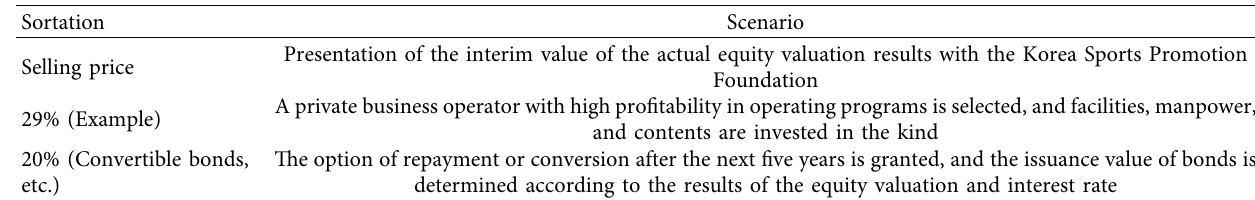
Table 9: Scenario for the sale of